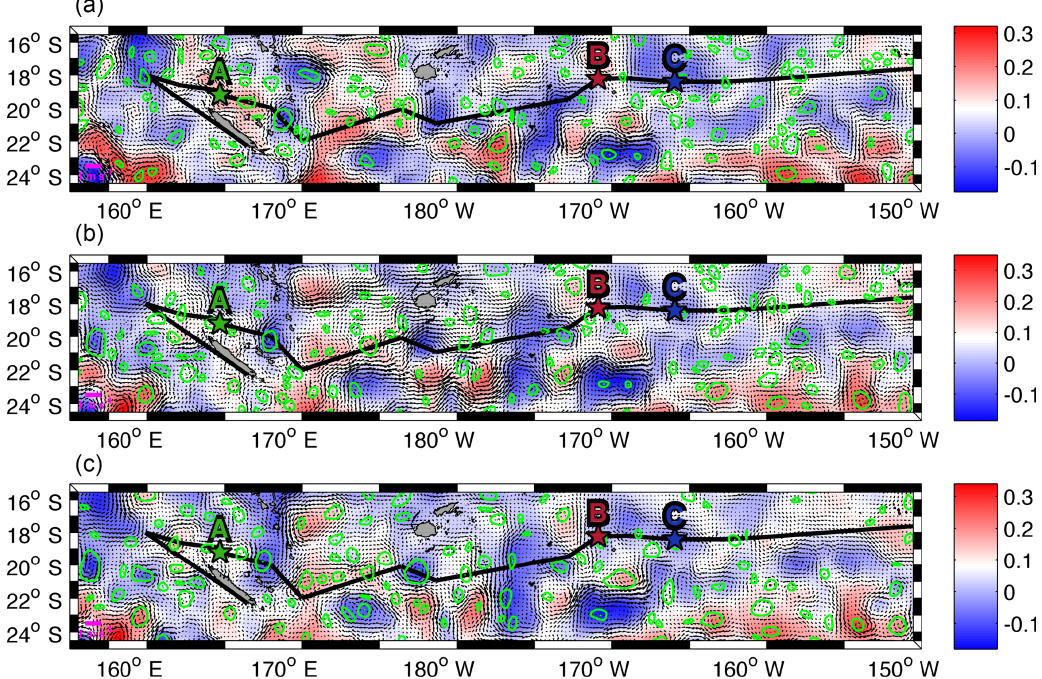
Figure 4. Daily sea surface level anomaly (m, colour bar) and velocity field (ms − 1 ) from the total altimetry-derived surface product for the first day of LDA (25 February, a ), LDB (15 March, b ) and LDC (23 March, c ). Contours of LAVD-detected structures are drawn in green. The centre of the structures is also indicated by a green point. The ship track and locations of OUTPACE LD stations are indicated with the black line and coloured stars as in Fig.